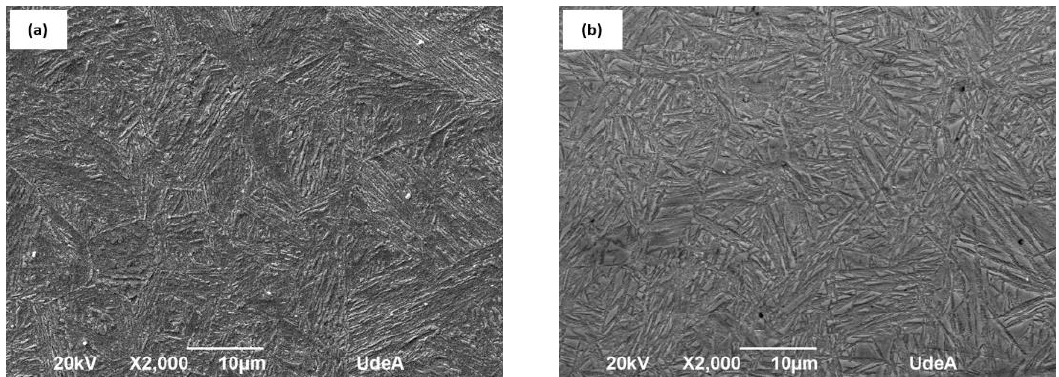
Figure 8. Secondary electron SEM images of the microstructure of the Q&T condition: ( a ) for core and ( b ) case steel.